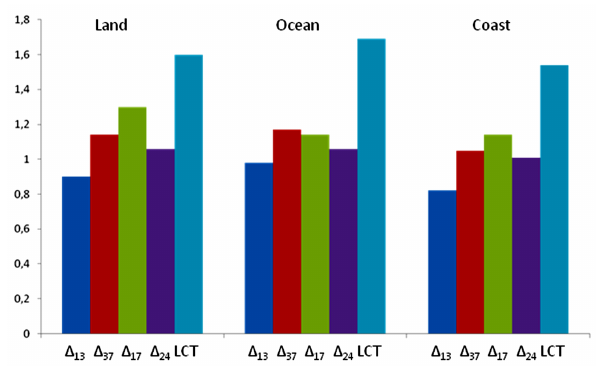
Figure 2. Relative sensitivity ( S i ) of the NN evaluated for five in- puts ( (cid:49) 13 , (cid:49) 37 , (cid:49) 17 , (cid:49) 24 , LCT), for three different background surfaces.